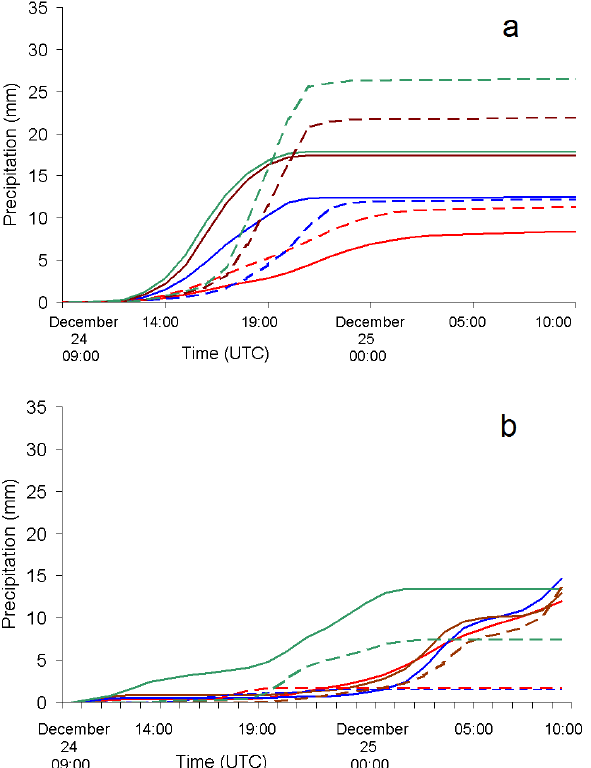
Figure 6. Modeled cumulative precipitation between (a) the simple ice (solid lines) and Reisner-Graupel (dashed lines) in MM5 and (b) WSM3 (solid lines) and Thompson (dashed lines) explicit moisture schemes in WRF and the di ff erence in domains. Domain 1: red, domain 2: blue, domain 3: brown, and domain 4: